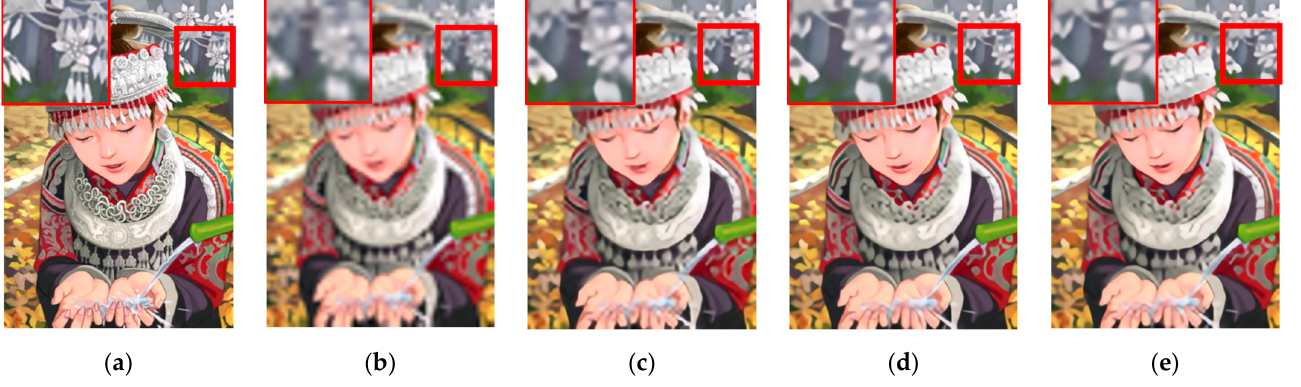
Figure 18. Visual evaluation for a scale factor of 4 × on the image “COMIC” from Set14: ( a ) Ground